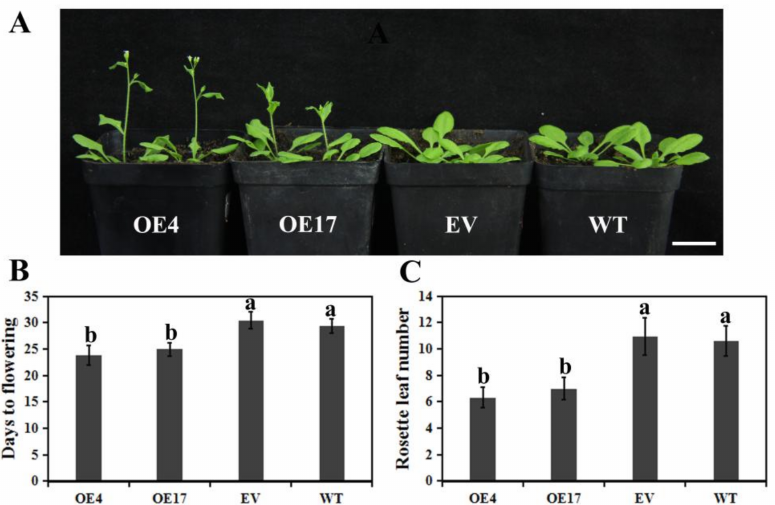
Figure 4. Early flowering phenomenon in CpWRKY75 transgenic Arabidopsis. ( A ) The flowering phenotype of 24-day-old transgenic Arabidopsis, EV and WT. Bar denotes 2 cm. ( B ) Days to flowering for transgenic Arabidopsis, EV and WT. ( C ) The number of rosette leaves at flowering of transgenic Arabidopsis, EV and WT. Values are means ± SD (n = 20). Lowercase letters shown above the columns indicate significant differences (one-way ANOVA, Duncan’s multiple range test, p <